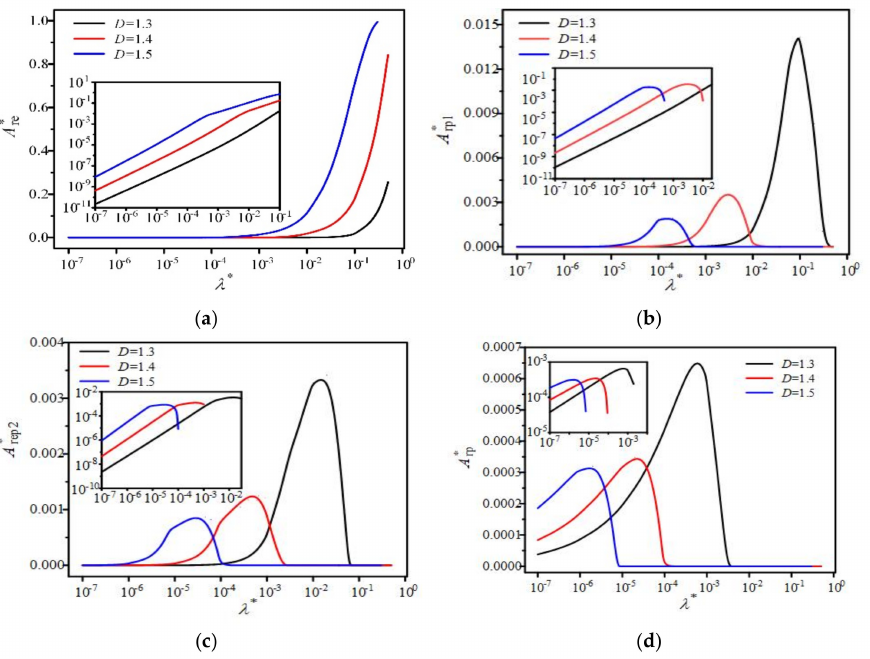
Figure 7. The real contact area A r * in different contact stages versus λ * with various D . ( a ) Dimension- less elastic deformation area A re * versus λ *. ( b ) Dimensionless elastoplastic deformation area A rep1 * in the first stage versus λ *. ( c ) Dimensionless elastoplastic deformation area A rep2 * in the second stage versus λ *. ( d ) Dimensionless plastic deformation area. A rp * versus λ * .